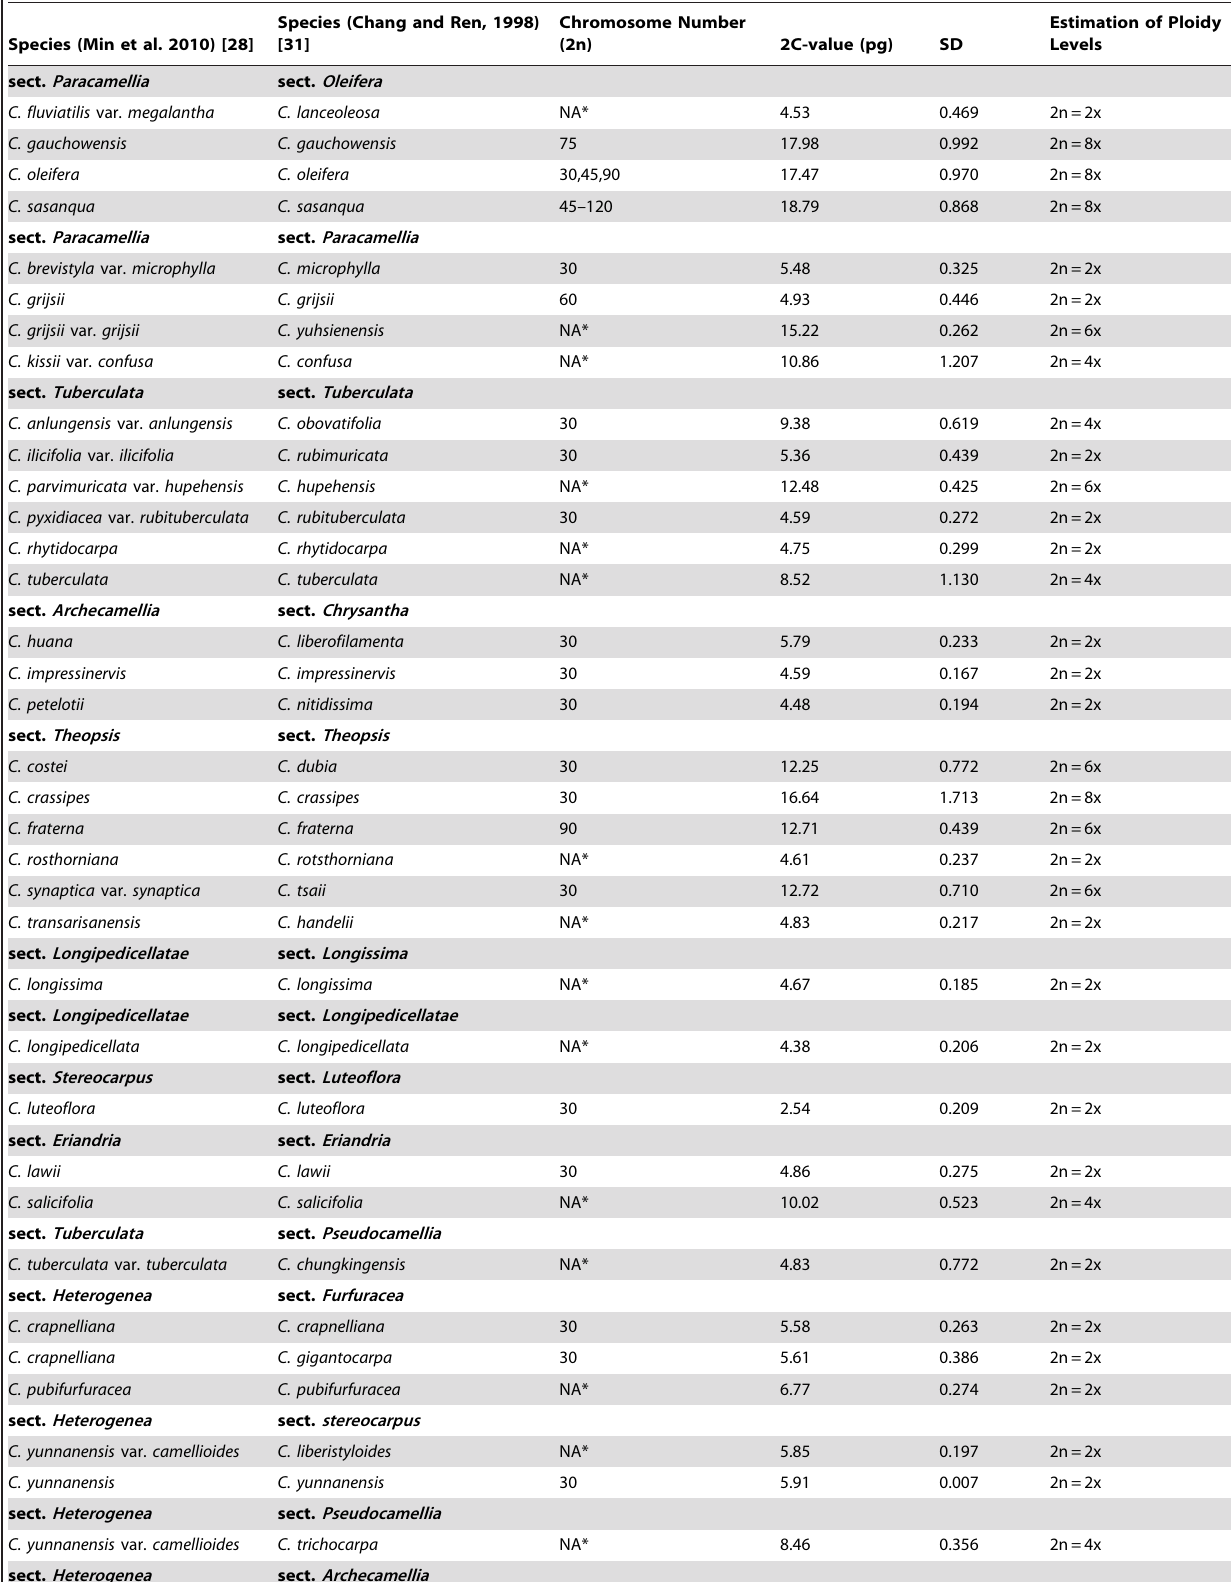
Table 5. Nuclear DNA amount of representing species in the genus Camellia estimated with flow cytometry.